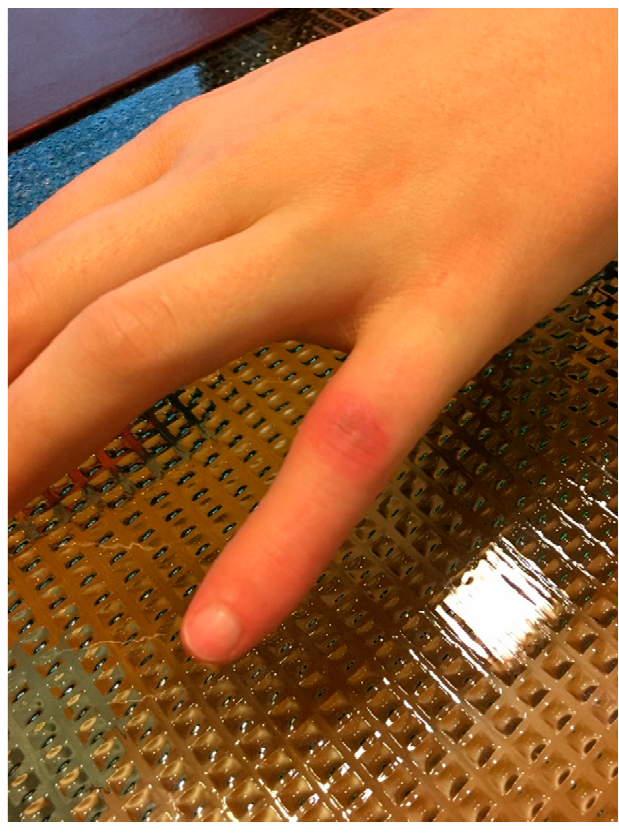
Figure 1. Sores at PIPJ.